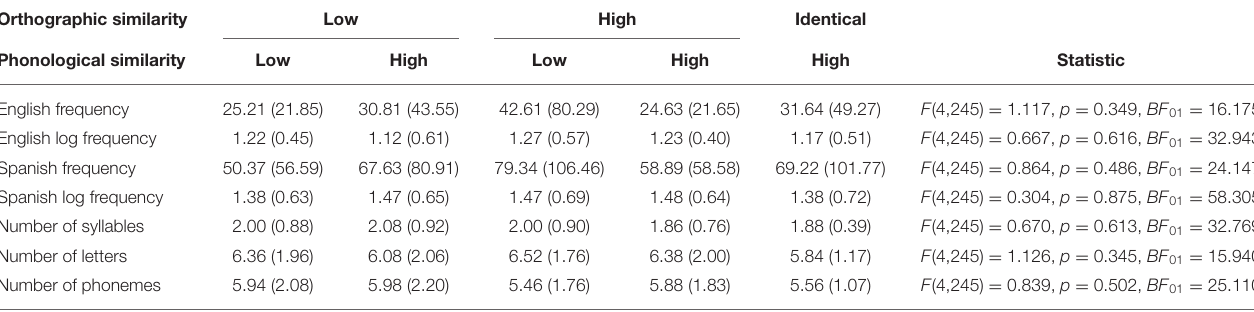
TABLE 1 | Means, standard deviations, and statistics for variables stimuli were matched on. Orthographic similarity Low High Identical Phonological similarity Low High Low High High